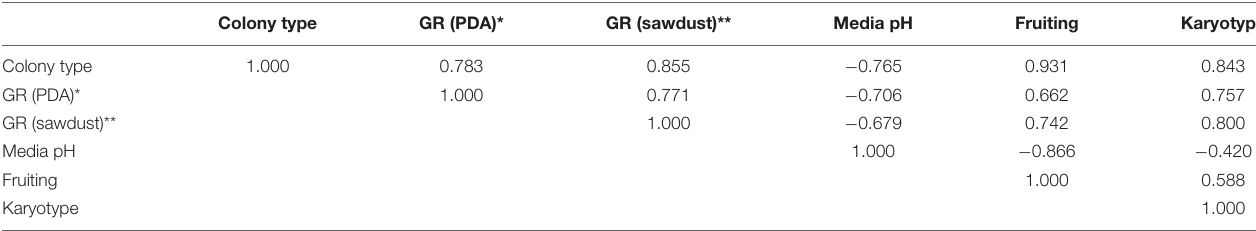
TABLE 1 | Correlation analysis among different characteristics and